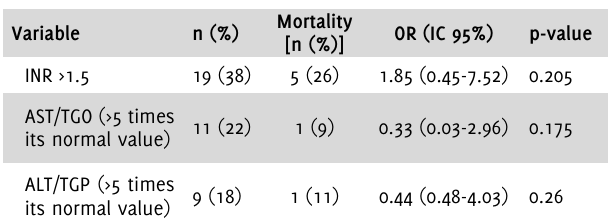
Table 1 . Relation of variables and